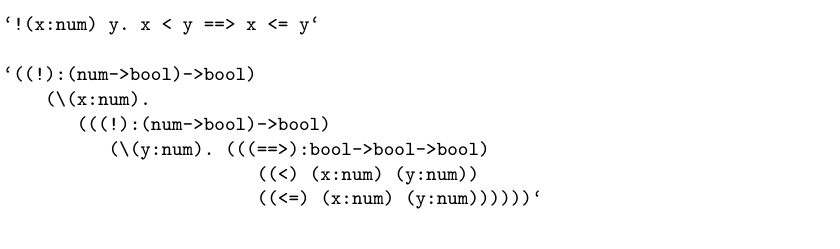
Fig. 7. Concrete and primitive syntax for the same expression in HOL